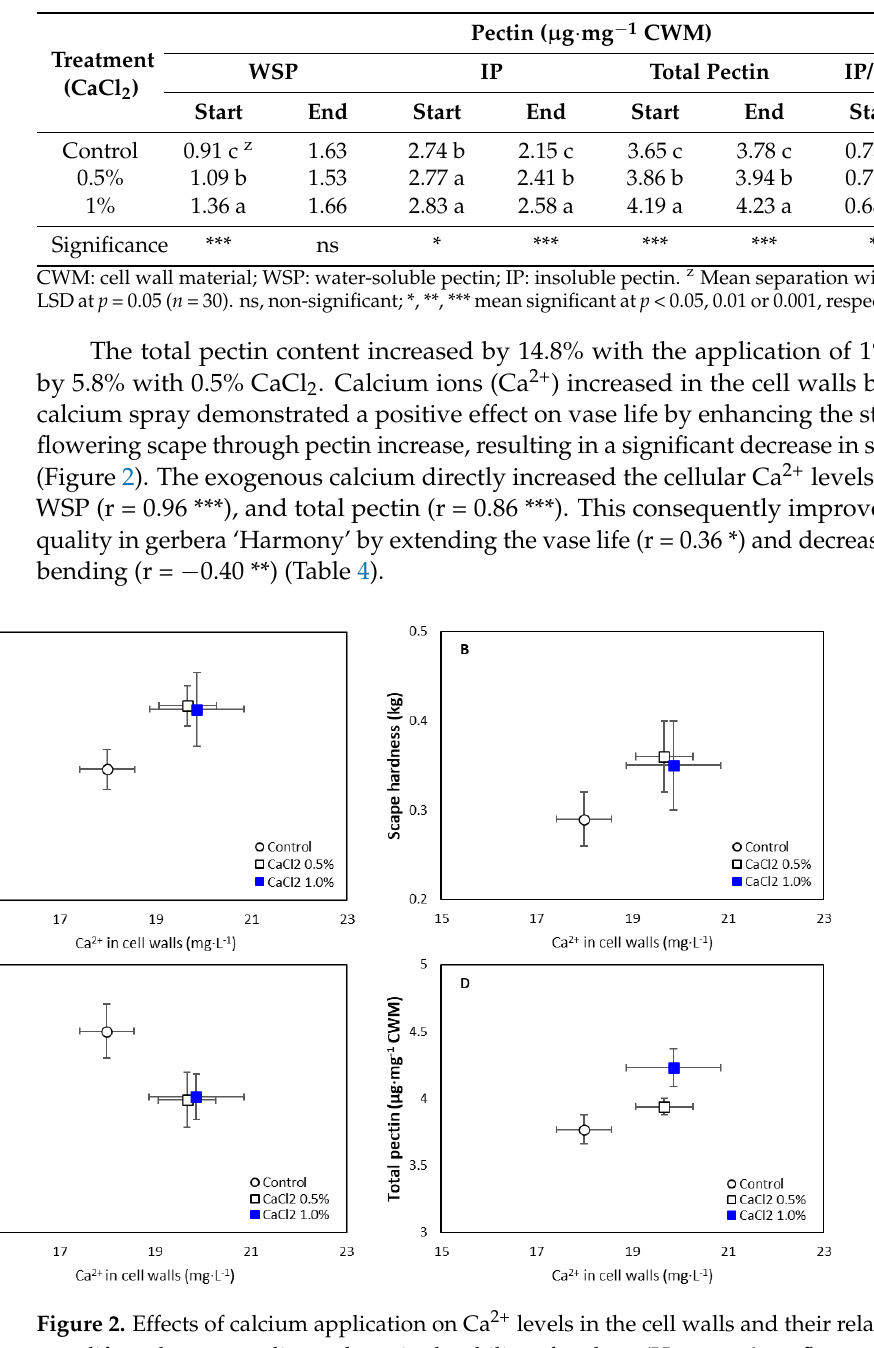
Table 3. Effects of preharvest spraying of CaCl 2 on pectin content in the cell walls of gerbera ‘Harmony’ cut flowers at the start and end of vase life.